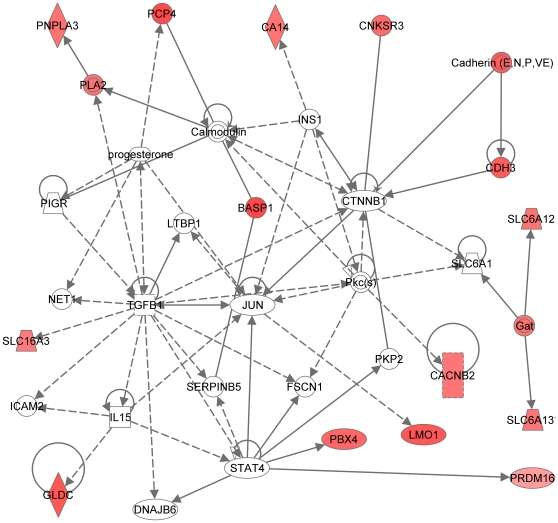
Second most significant molecular network generated by the Ingenuity software.Network is generated from our microarray dataset with RPE-specific expression (114 entries; see text). For explanation of symbols on the diagrams see legend Figure 7. The main functionalities given by Ingenuity for this molecular network are cellular development, hematological system development and function and connective tissue development and function. Highlights in this network include: (a) The dual presence of GABA receptors SLC6A12 [NM_003044] and SLC6A13 [NM_016615]; the presence and interactions of (b) the insulin-1 (INS1) protein and (c) the hormone progesterone.